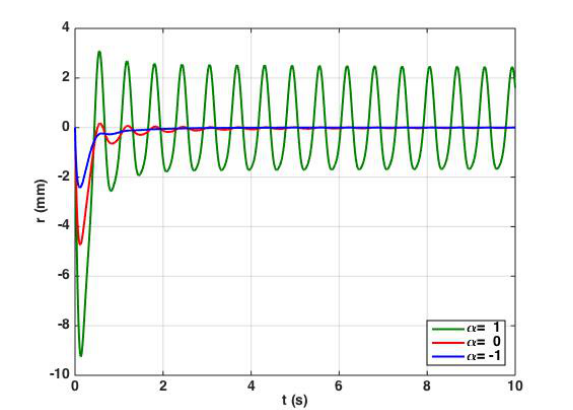
Figure 2. The solutions of r for different values of the bifurcation parameter α . These solutions exhibit different behaviors of the coupled oscillators, as we changed the bifurcation parameter α . For α = − 1 < 0 we have damped oscillations, and for α = 0 we faced critical ones. For α = 1 spontaneous oscillation was the result. In this figure a = α + 1, b = c = ω = 5, d = a − 2, (cid:101) = 0.1, c 1 = c 2 = c 3 = c 4 = (cid:101) , β = A 21 and δ = 0.1. The initial conditions were r 1 = r 2 = 1, φ 1 = π and φ 2 = π /6.